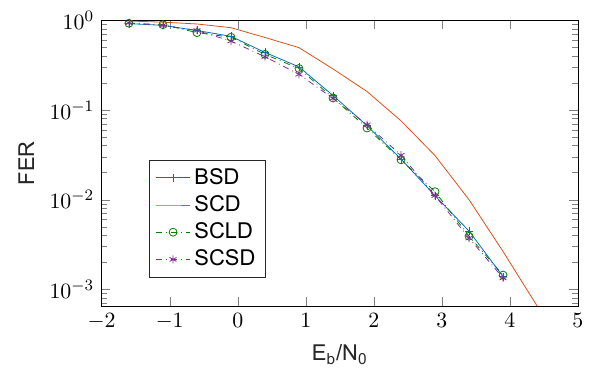
Figure 6 – FER of the (128 , 64) polar code using the BSD, SCD, SCLD and SCSD algorithms.